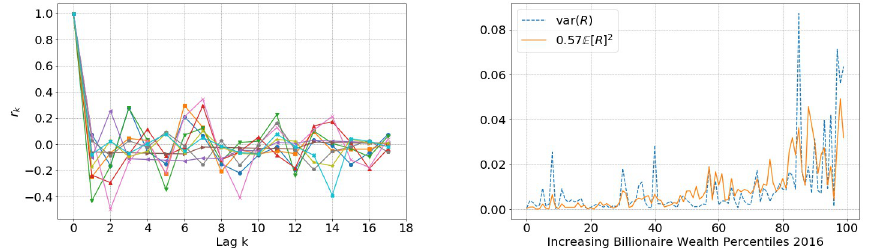
Fig 3. Left: autocorrelation of a sample of billionaire ROR indicating independence in returns. Right: average annual billionaire returns from 2008–2016 Forbes list [19], showing mean and variance relationship for increasing wealth percentiles as in